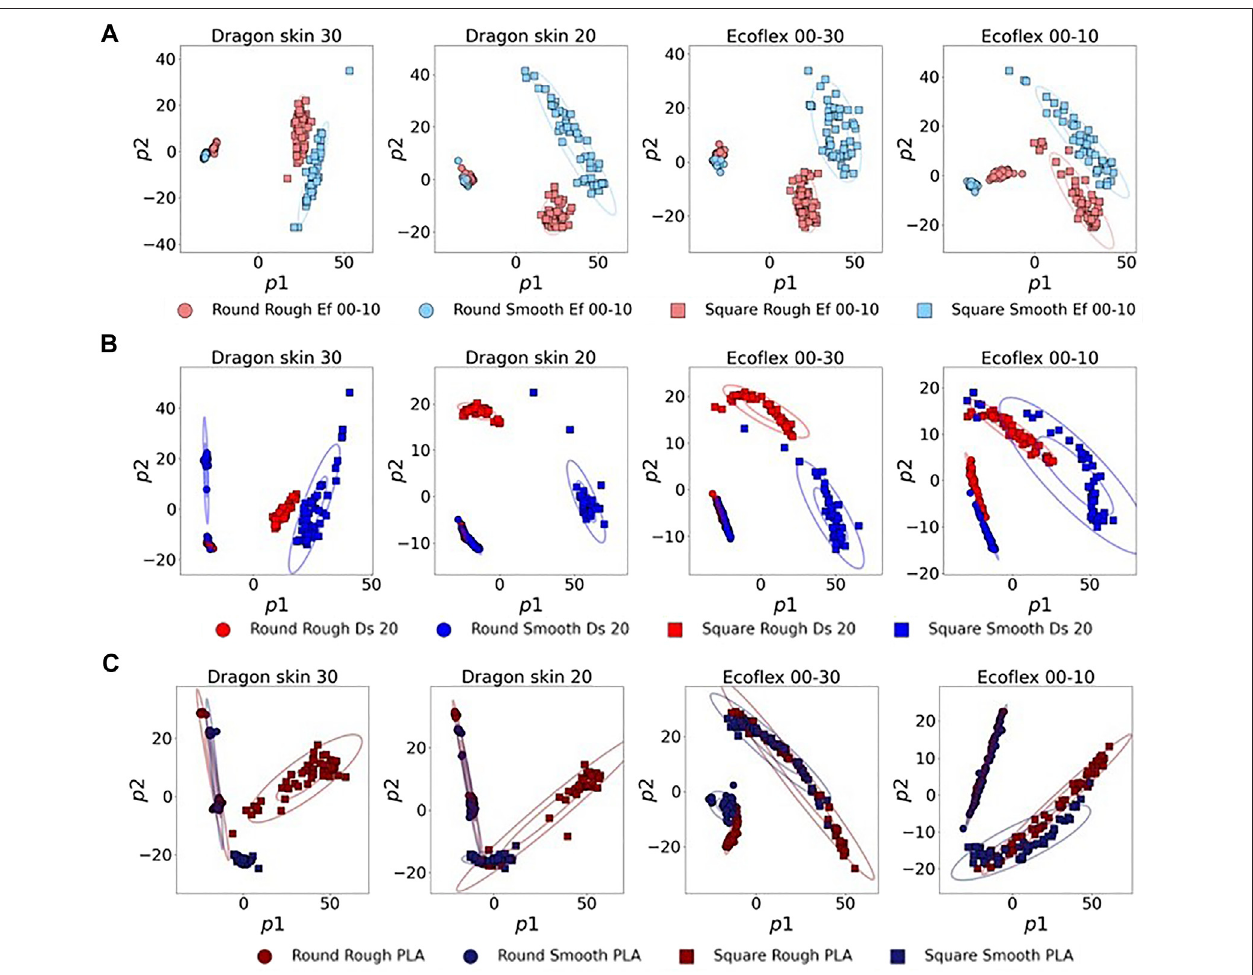
FIGURE 10 | 2D variance retention plots when testing the fi lter ’ s material on the three different subsets made with test objects of the same material: Eco fl ex 00 – 10 (A) , Dragon Skin 20 (B) , and PLA (C) . ‘ Ef ’ and ‘ Ds ’ indicate Eco fl ex and Dragon Skin, respectively.